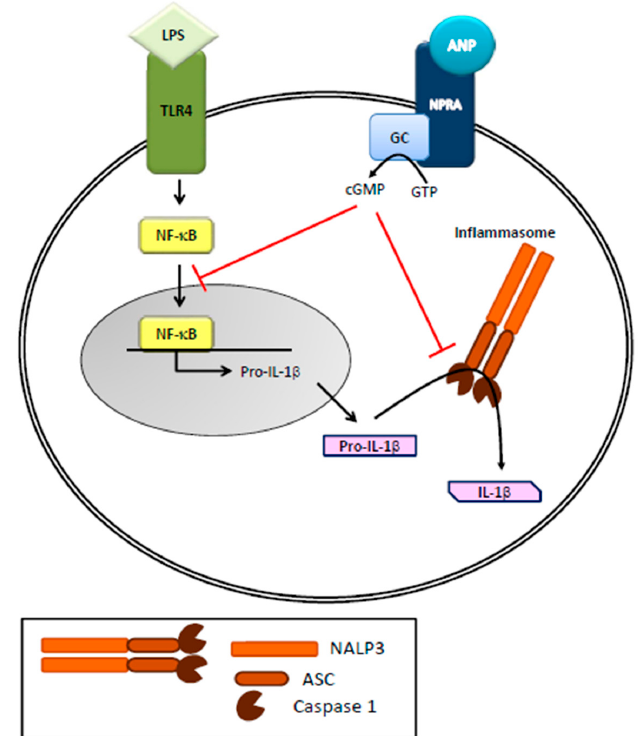
Figure 2. Role of ANP on inflammasome activation in immune cells. ANP, by binding to its receptor (NPRA), increases cGMP levels and inhibits LPS-induced IL-1 β secretion in human THP-1